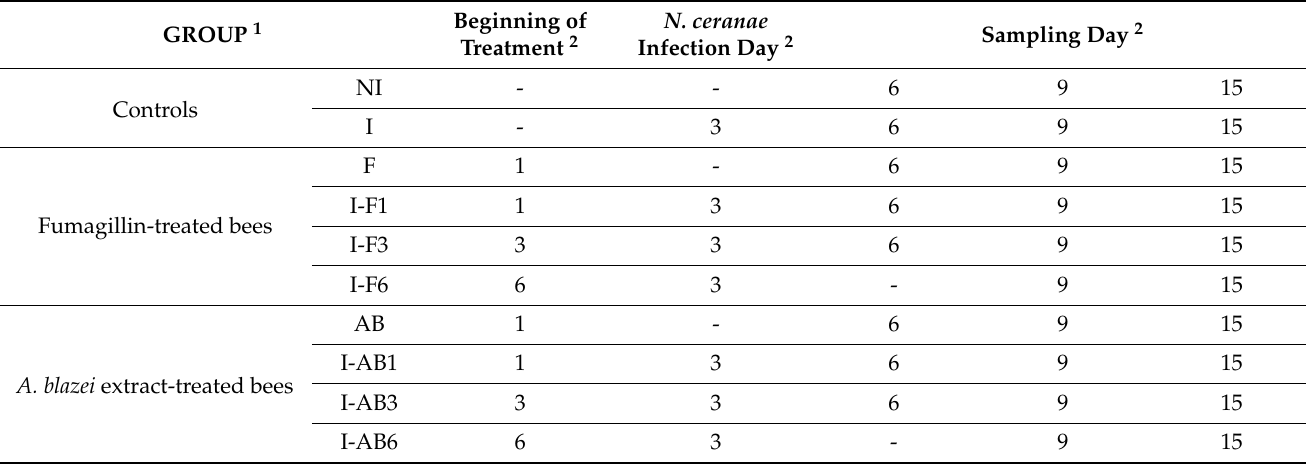
Table 1. Experimental